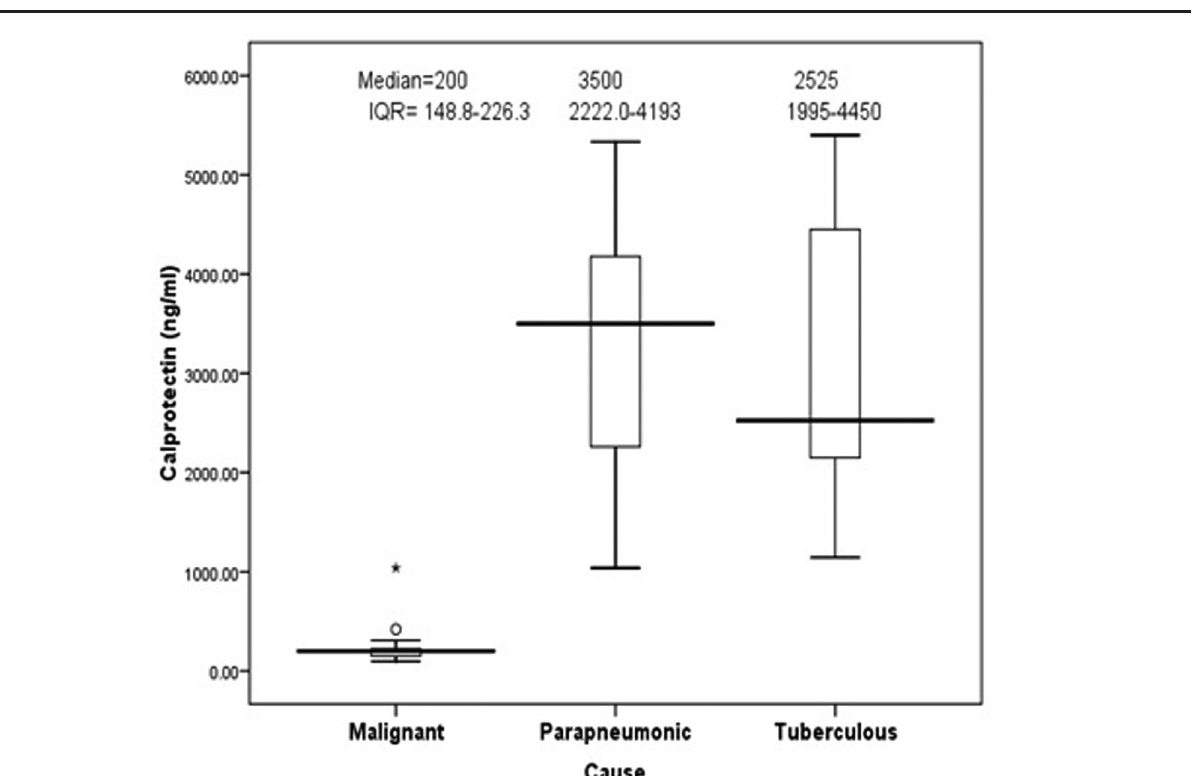
Box plot showing the median and the interquartile range (IQR) of pleural calprotectin.